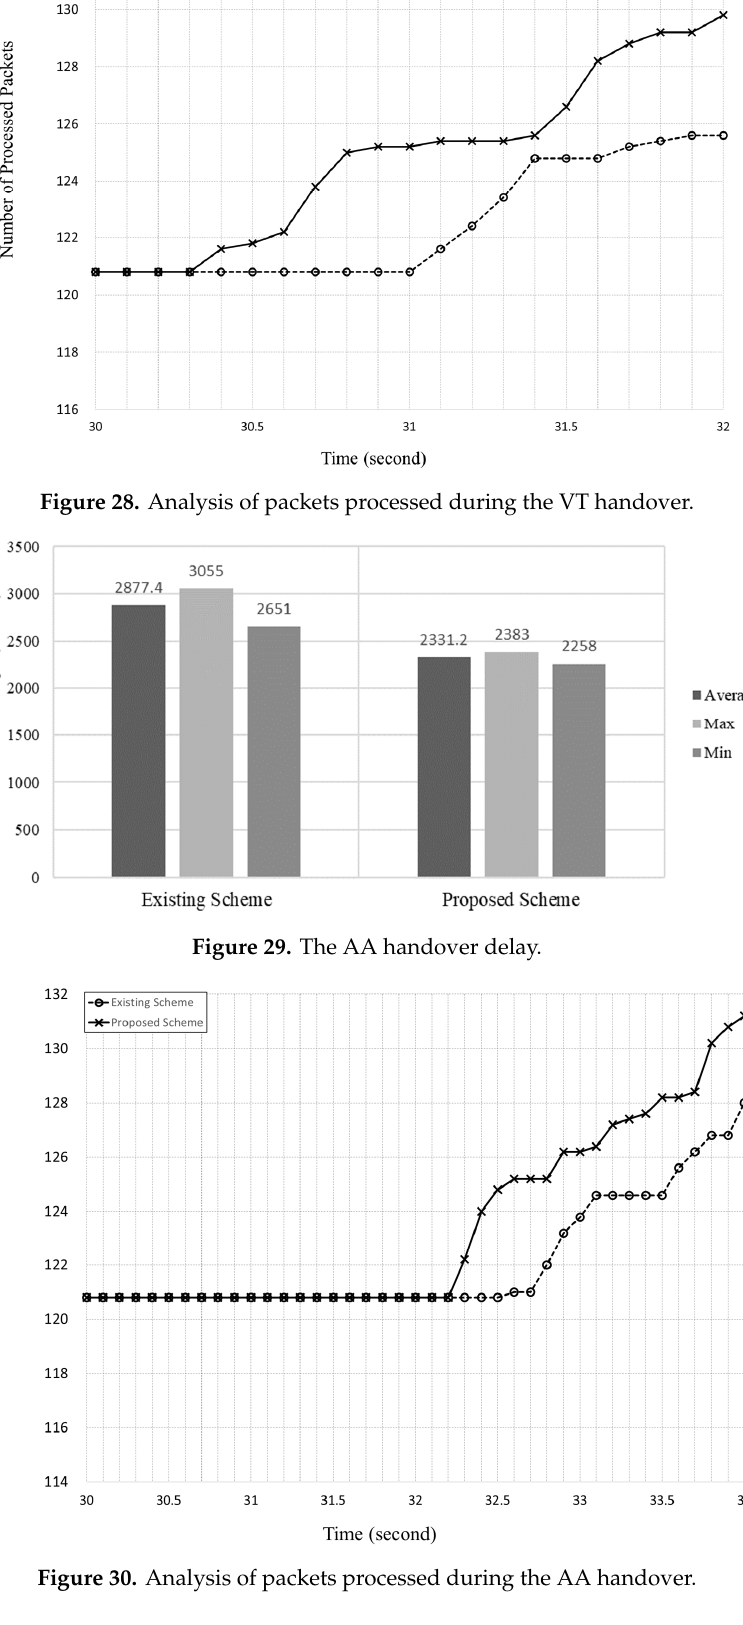
Figure 28. Analysis of packets processed during the VT handover.